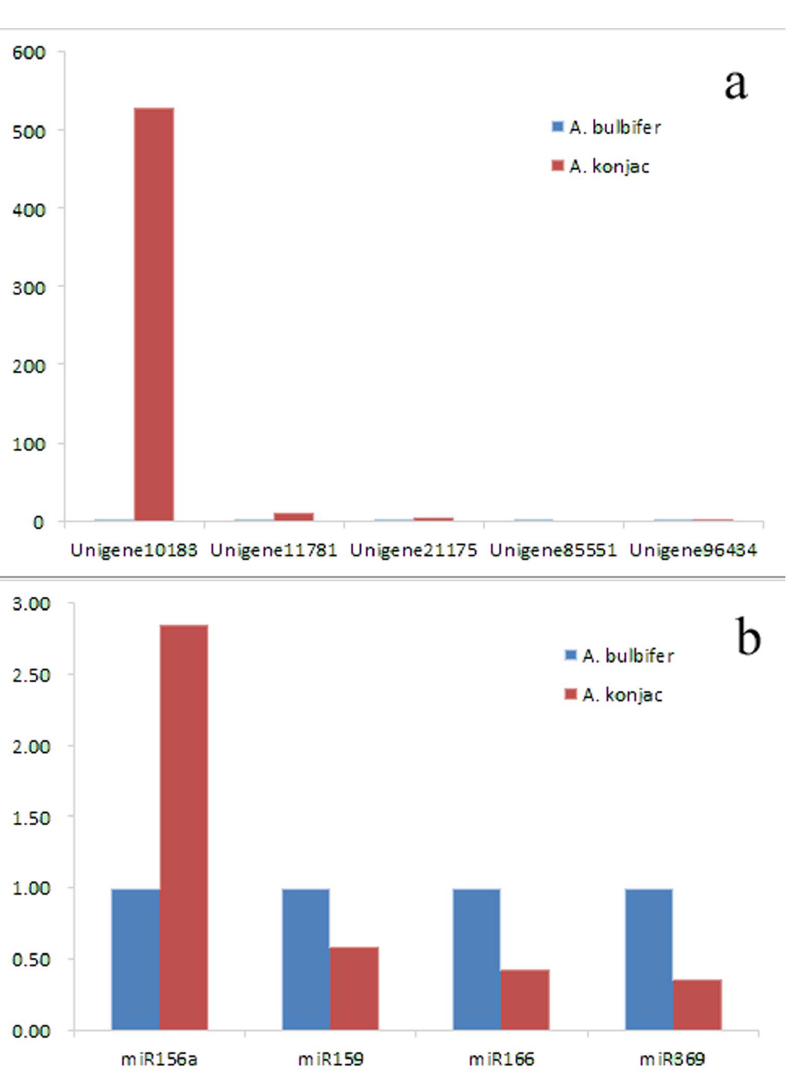
Figure 7. Validation of candidate unigenes and miRNAs in A.konjac and A.bulbifer by qRT-PCR. (a) Five candidate unigenes show differential expression patterns by qRT-PCR in A. konjac and A. bulbifer . (b) Four candidate miRNAs show differential expression patterns by qRT-PCR in A. konjac and A. bulbifer . doi:10.1371/journal.pone.0095428.g007 PLOS ONE |